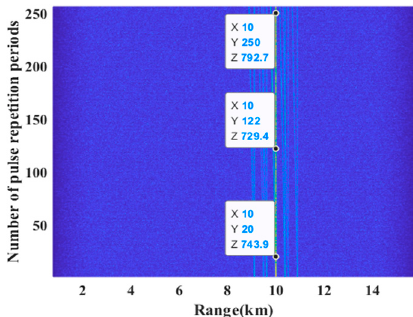
Figure 13. Pulse compression result of multi-period echo signal after compensating based on the improved Keystone algorithm.